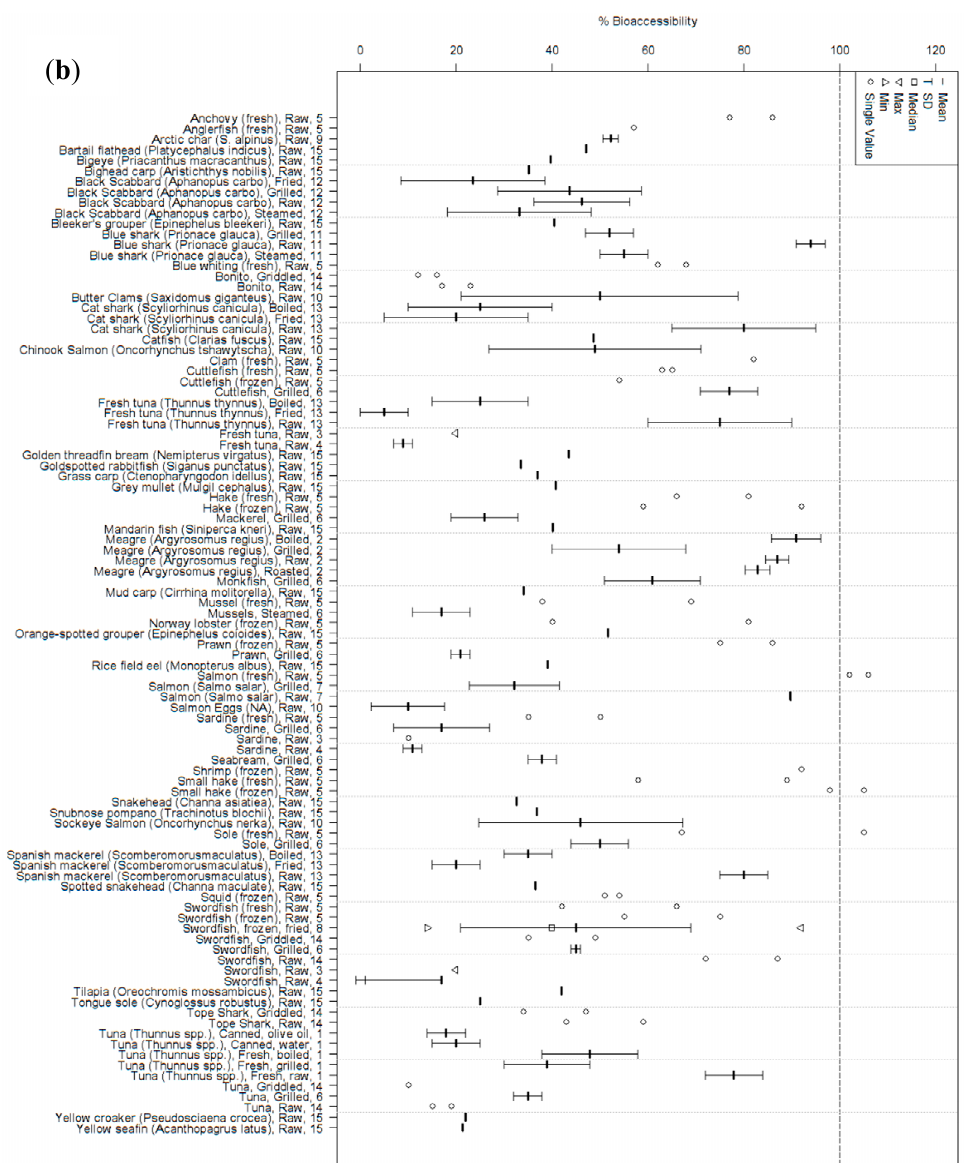
Figure 3. Summary of in vitro studies on bioaccessibility of Hg to humans from fish consumption for ( a ) MeHg and ( b ) total Hg. In both, each column represents a single species of fish, prepared and/or packaged in a particular way. The numbers along the Y-axis indicate studies, as outlined in Table S4.